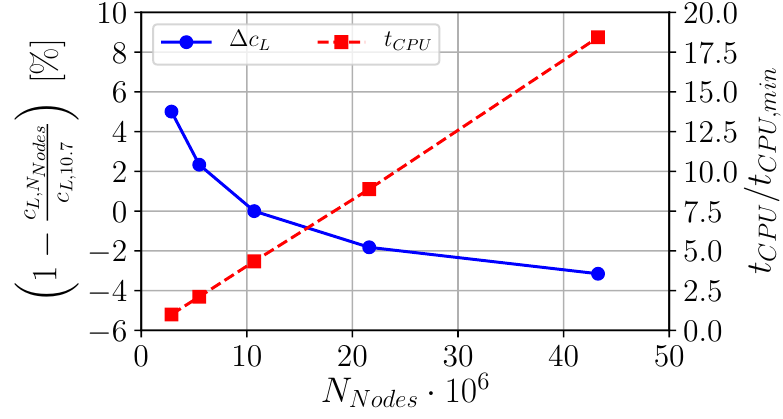
Figure 11. Variation of the lift coefficient c L and normalized CPU time for different grid resolutions specified by the number of cells N Nodes . The medium resolution is taken as the